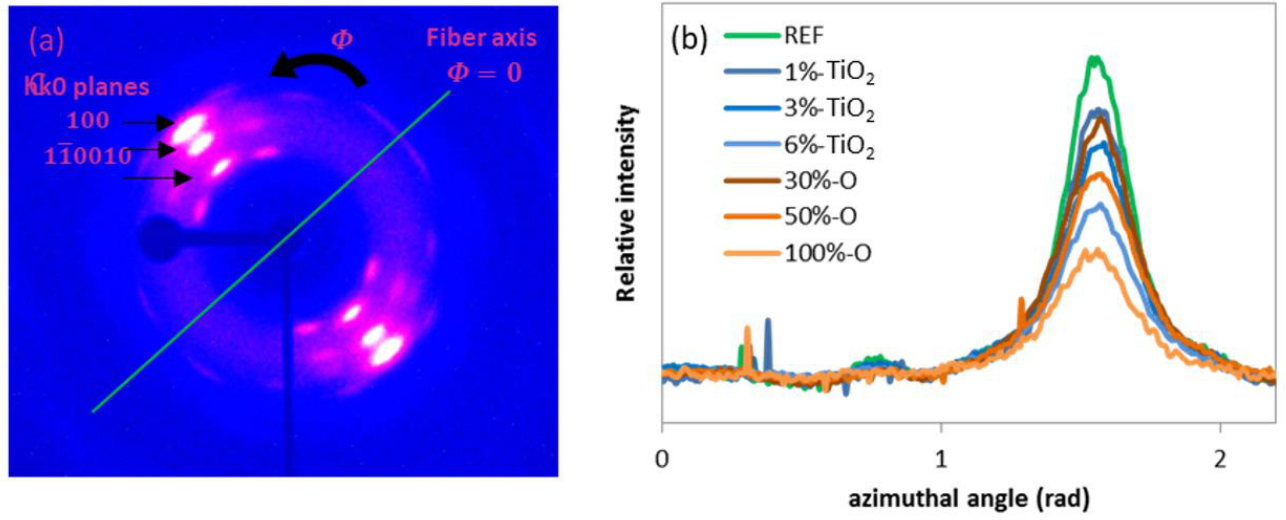
Figure 5. ( a ) WAXS 2D pattern of the reference and ( b ) X-ray intensity of crystalline plane 100 versus the azimuth angle.